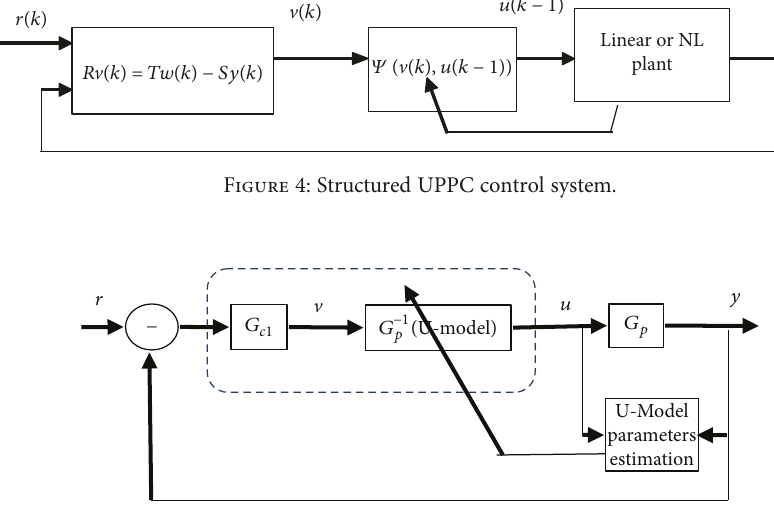
Figure 5: Adaptive U-model control